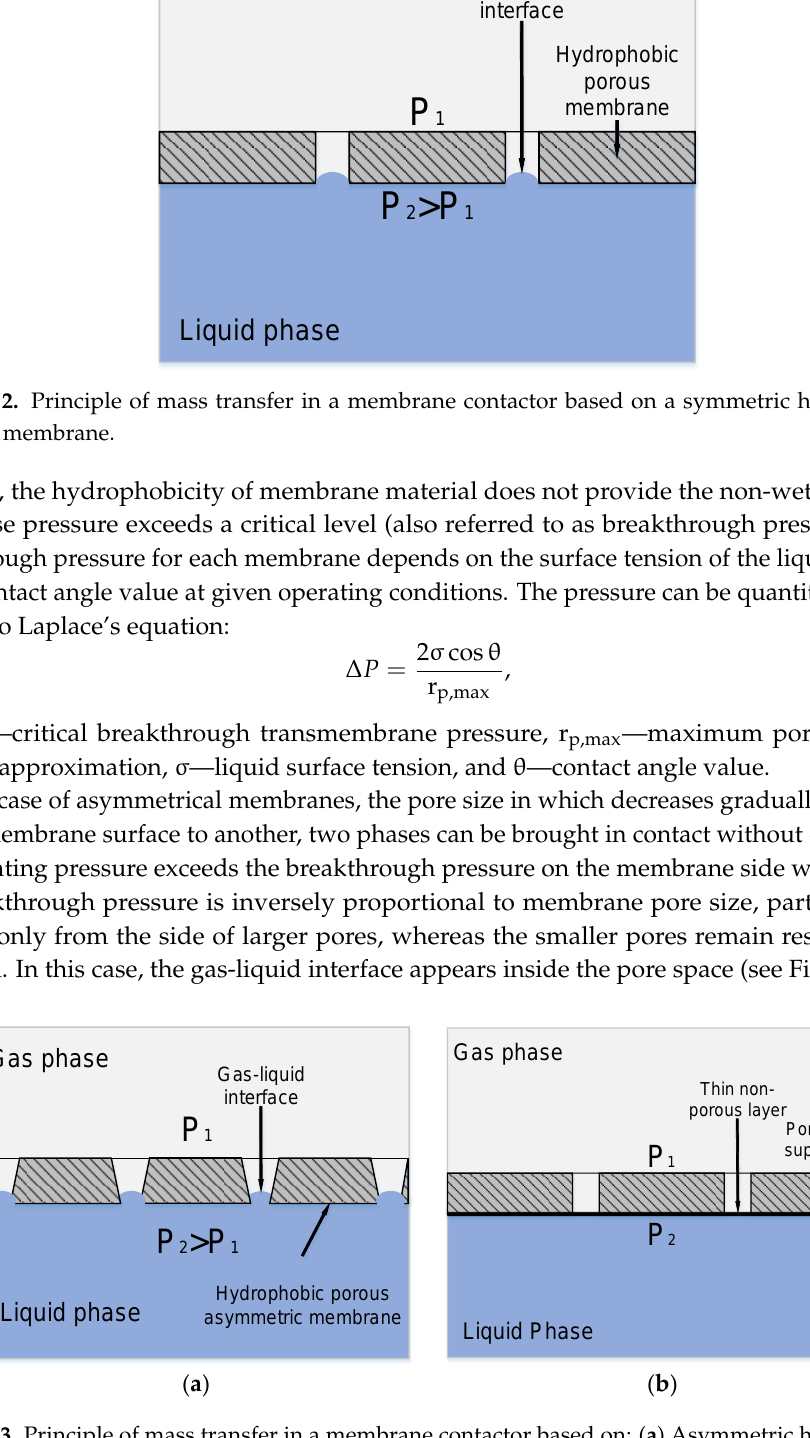
( b ) Figure 4. Principle of mass transfer in a membrane contactor: ( a ) Absorption of a component from the gaseous phase; and, ( b ) Desorption of a component from the liquid phase. As can be seen from Figure 4a,b, the ideal case of membrane contactor operation provides a way to implement both absorption and desorption process at the clearly defined gas-liquid membrane interface. This means that the area of contact and mass transfer remains constant, and all of the equipment operates with equal productivity, even when the process conditions or the liquid properties are changed. As noted above, hollow fiber membranes provide large surface area per apparatus volume (up to 10,000 m 2 /m 3 ), thus making the equipment compact (with small dimensions and weight) [4,5]. As shown in [20], the dimensions and weight of the membrane contactor can be decreased by 72% and 66%, respectively, as compared to conventional absorption columns. Furthermore, theoretical estimations indicate [21] that the dimensions of an absorber can be reduced to 10 times when replaced with a membrane contactor.